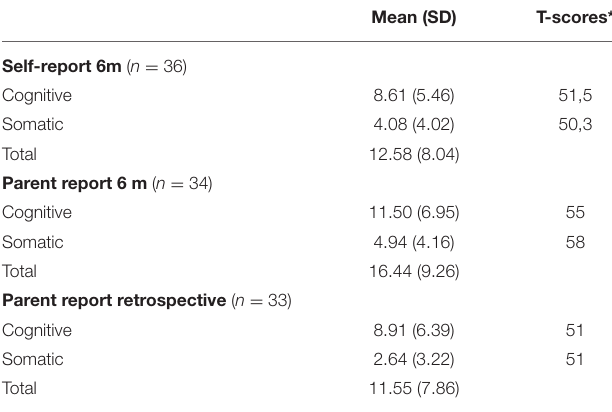
TABLE 4 | Health and behavior